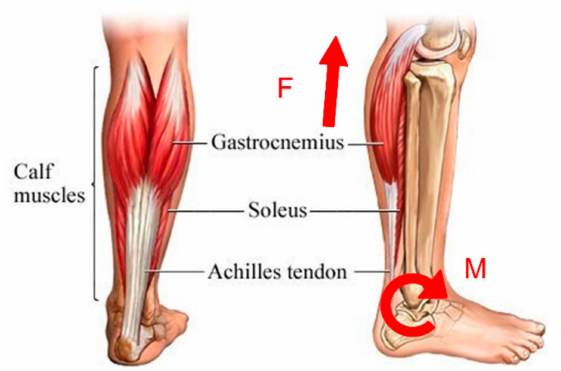
Figure 2. Thecompositionofthecalfmuscles, whichplaysakeyroleinpropellinghumanbodyforward[44].